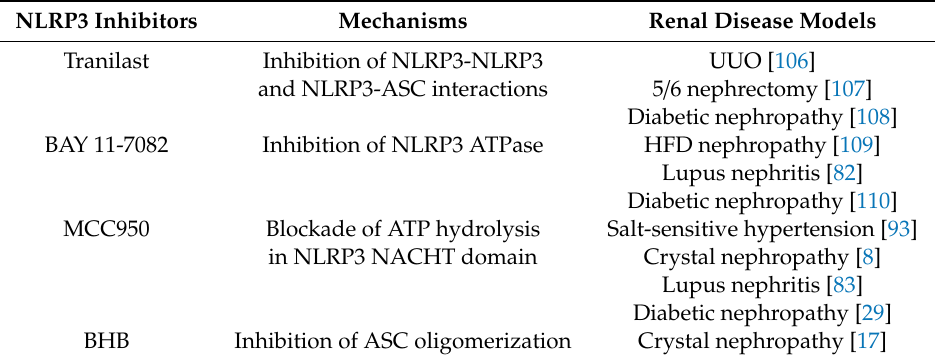
Table 1. The mechanisms and related renal disease models of NLRP3